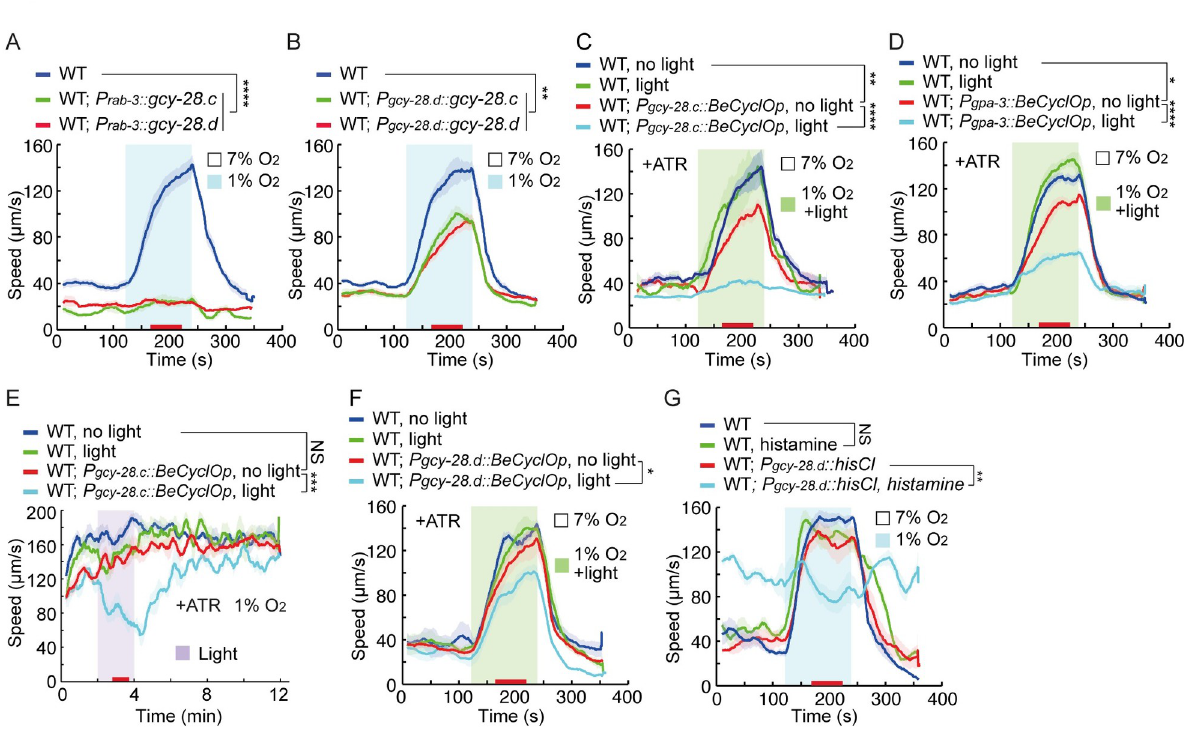
Fig 4. Acute cGMP production robustly inhibits locomotory responses to hypoxia. (A, B) Locomotory responses to 7% to 1% O 2 stimuli of animals of indicated genotype: WT and WT expressing gcy-28 . c or gcy-28 . d cDNA pan-neuronally from the rab-3 promoter (A); and WT and WT overexpressing gcy-28 . c or gcy-28 . d cDNA from the gcy-28 . d promoter, which drives expression selectively in the AIA neurons (B). ���� = p < 0.0001, and �� = p < 0.01. ANOVA, Tukey multiple comparison. (C–F) Optogenetic stimulation of cGMP production using BeCyclOp from the gcy-28 . c (C and E), gpa-3 (D) or gcy-28 . d (AIA neurons) (F) promoters. L4 animals of each genotype were picked overnight to seeded plates containing ATR and assayed as adults. Blue light was delivered while O 2 levels were switched from 7% to 1% (C, D, and F). In (E), animals were constantly exposed to 1% O 2 , and blue light was applied in a 2-minute time window, as indicated. ���� = p < 0.0001, ��� = p < 0.001, �� = p < 0.01, and � = p < 0.05, and NS = not significant. ANOVA, Tukey multiple comparison. (G) Locomotory responses to 7% to 1% O 2 stimuli of animals with the indicated genotype: WT with or without 10mM histamine treatment, and WT expressing the Drosophila histamine-gated chloride channel HisCl1 in AIA neurons using the gcy-28 . d promoter treated with or without 10 mM histamine. L4 animals of each genotype were transferred to plates containing 10 mM histamine for 10 minutes and assayed as adults on histamine containing plates. �� = p < 0.01, and NS = not significant. ANOVA, Tukey multiple comparison. The source code underlying behavioral data can be found at https://github.com/wormtracker/zentracker. O 2 , oxygen; WT,